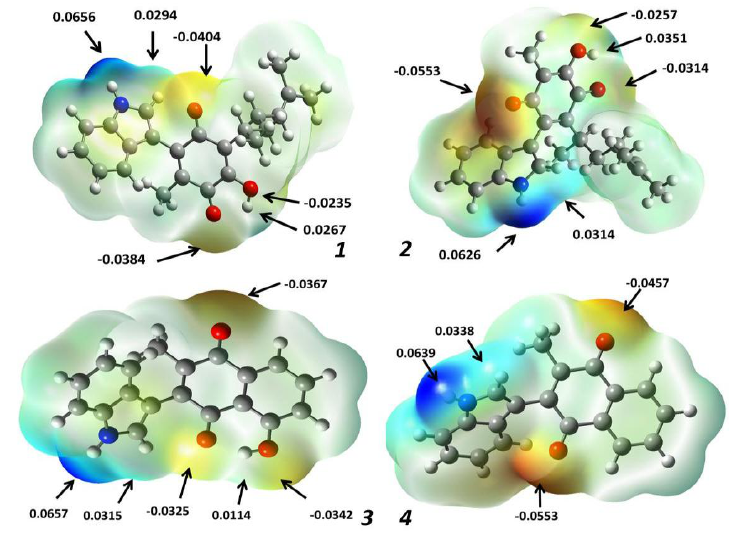
Figure 7. Molecular electrostatic potential surface of 1 – 4 .